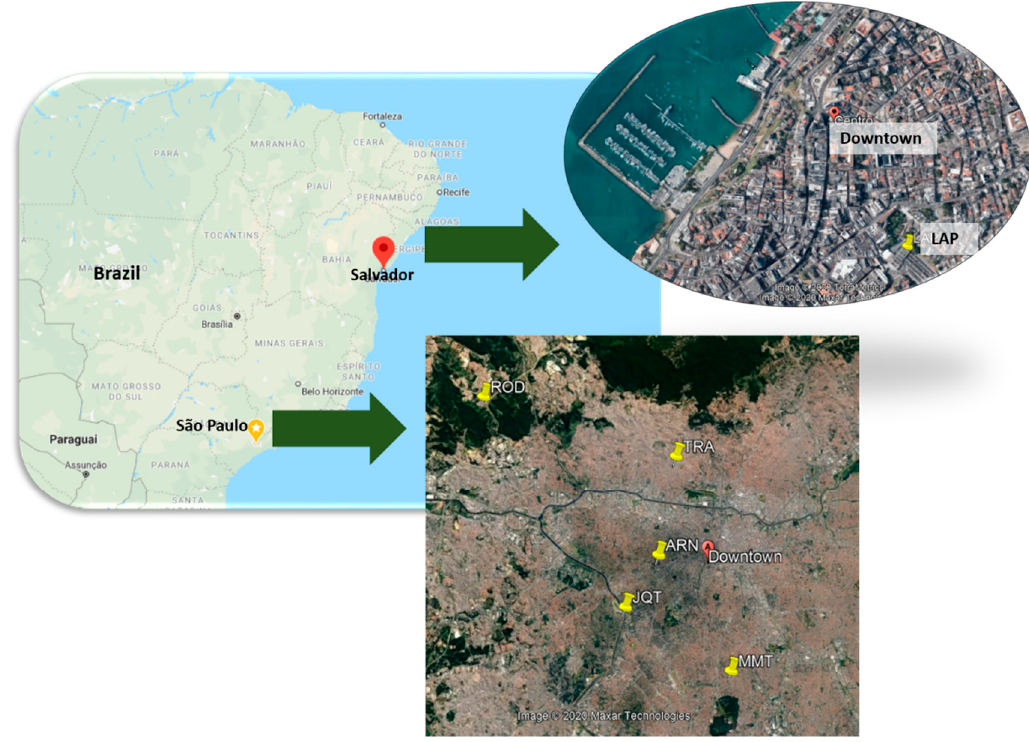
Figure 1. Map of Brazil showing the location of sampling sites in Salvador and São Paulo.